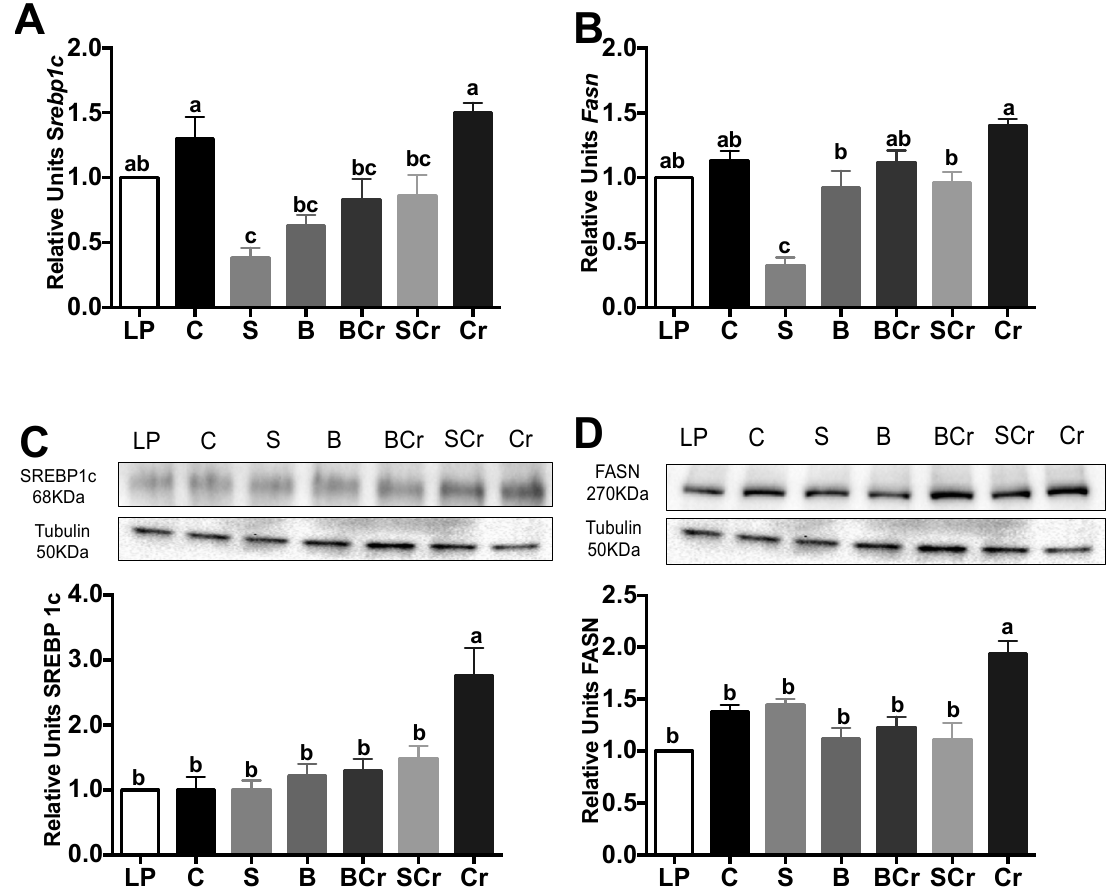
Figure 8. mRNA gene expression and Western blot analysis of SREBP1C and FASN in rats fed different types of proteins after a protein restricted period: ( A ) Srebp1c mRNA abundance; ( B ) Fasn mRNA abundance; ( C ) abundance of SREBP1c; and ( D ) abundance of FASN. Values are means ± SEM, n = 3. Different letter superscript indicates significant differences among groups, p < 0.05, a > b > c.